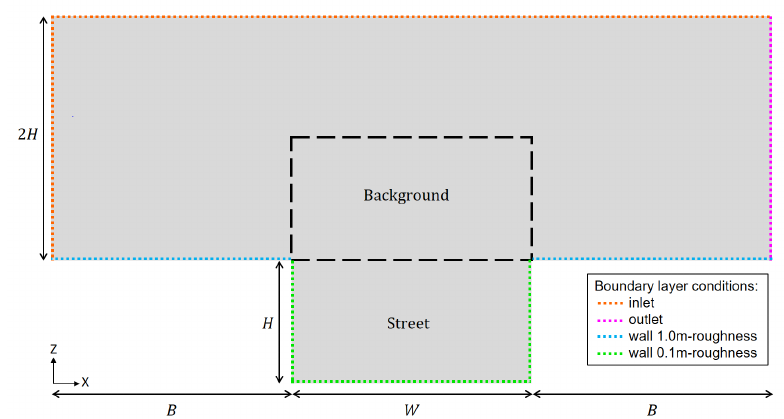
Figure 1. 2D scheme of the canyon geometry with the street and background domain borders, and the boundary conditions.